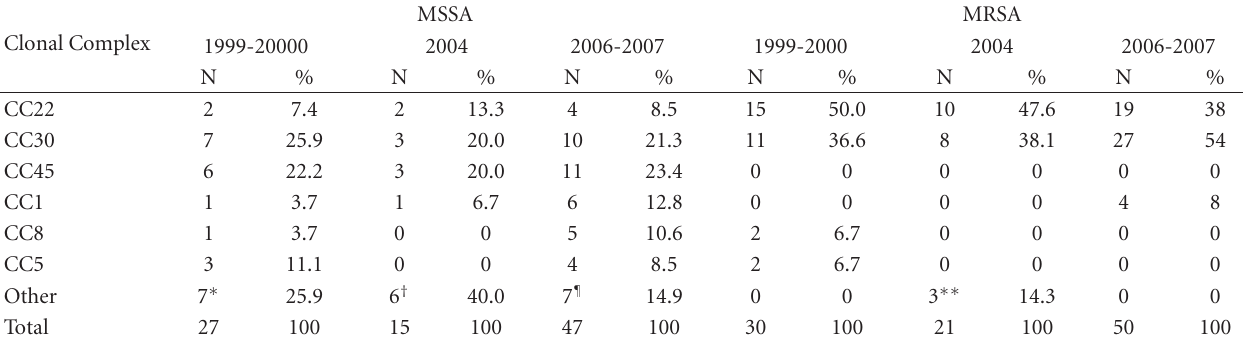
Table 3: Lineages of 190 S. aureus bacteraemia isolates from 1999-2000, 2004, and 2006.